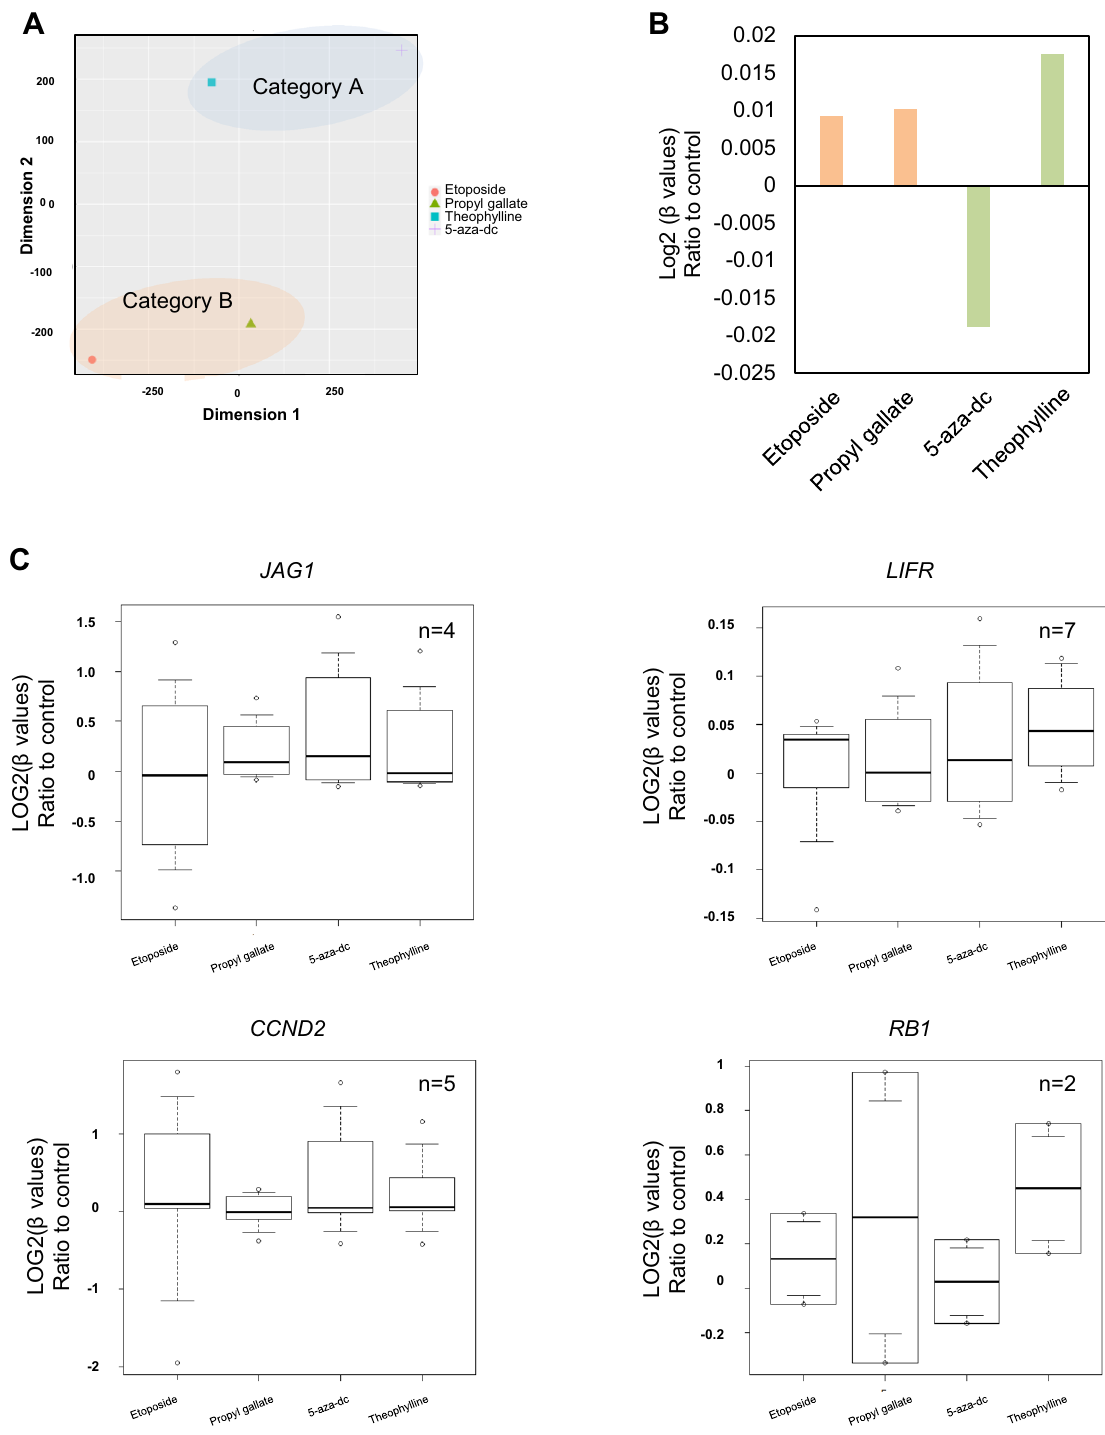
Figure 6. Validation of effects of chemicals on DNA methylations by RRBS. ( A ) t-SNE analysis of β-values relative to the vehicle control. ( B ) Changes in DNA methylation rates at all sites. Data are presented as the mean of log2 (β-values) ratio to the vehicle control. ( C ) Effects of hypermethylation agents on DNA methylation rate at CpG sites around the locus of JAG1 , LIFR , CCND2 , and RB1 genes. Data are presented as log2 (β-values) ratio to the vehicle control. The total number (n) indicates the number of CpG sites in each gene. See also Table